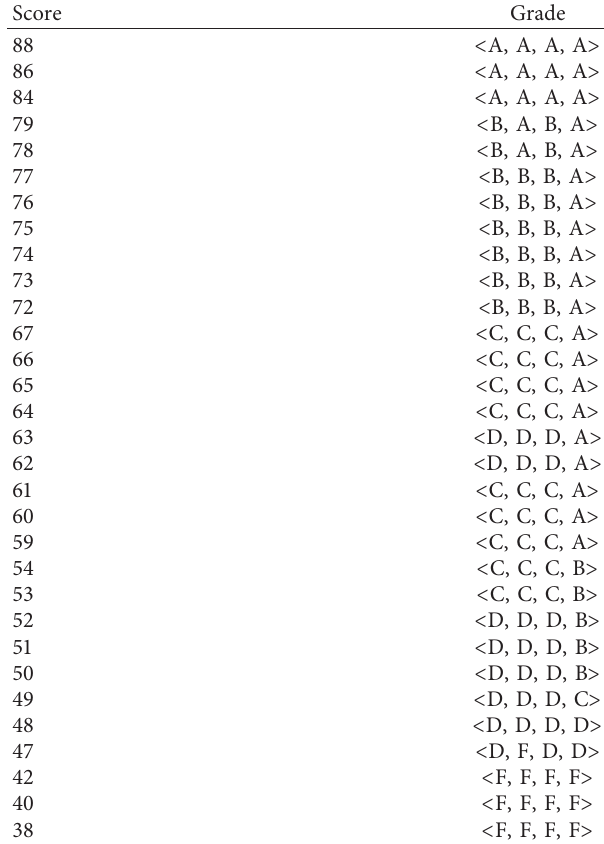
Figure 6: Divide in WD data set.